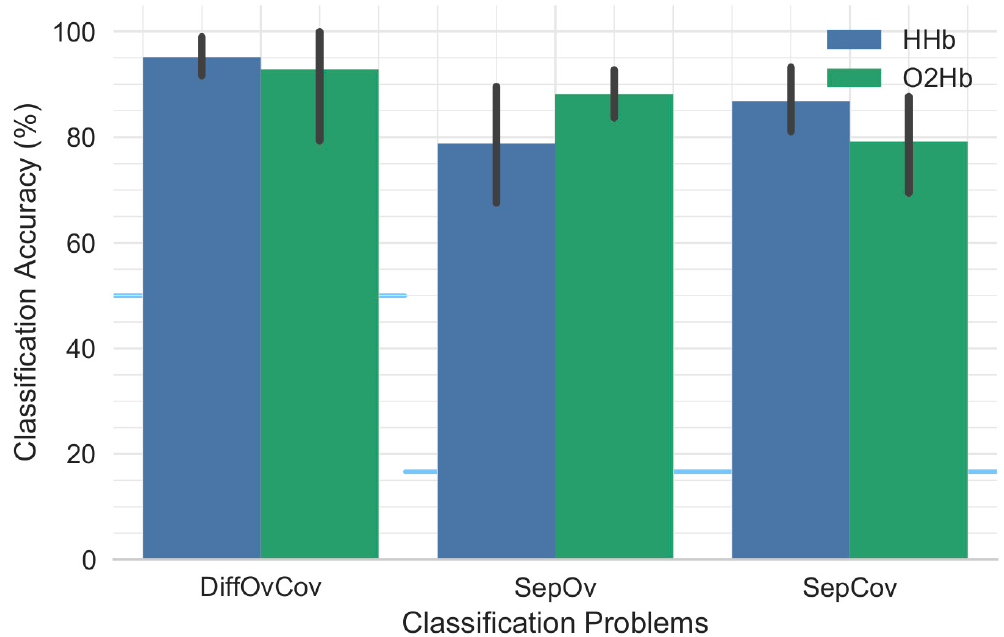
Figure 5. Mean classification accuracy for the different classification strategies. The height of each bar indicates mean classification performance and the error bars indicate bootstrapped 95% confidence intervals estimated by resampling participants (1000 bootstrap samples). The blue horizontal lines show the chance-level performance for the corresponding pairs of bars. Table 1. Individual classification performance sorted by handedness of the participants. The first number is classification accuracy based on HHb and the second is based on O2Hb.